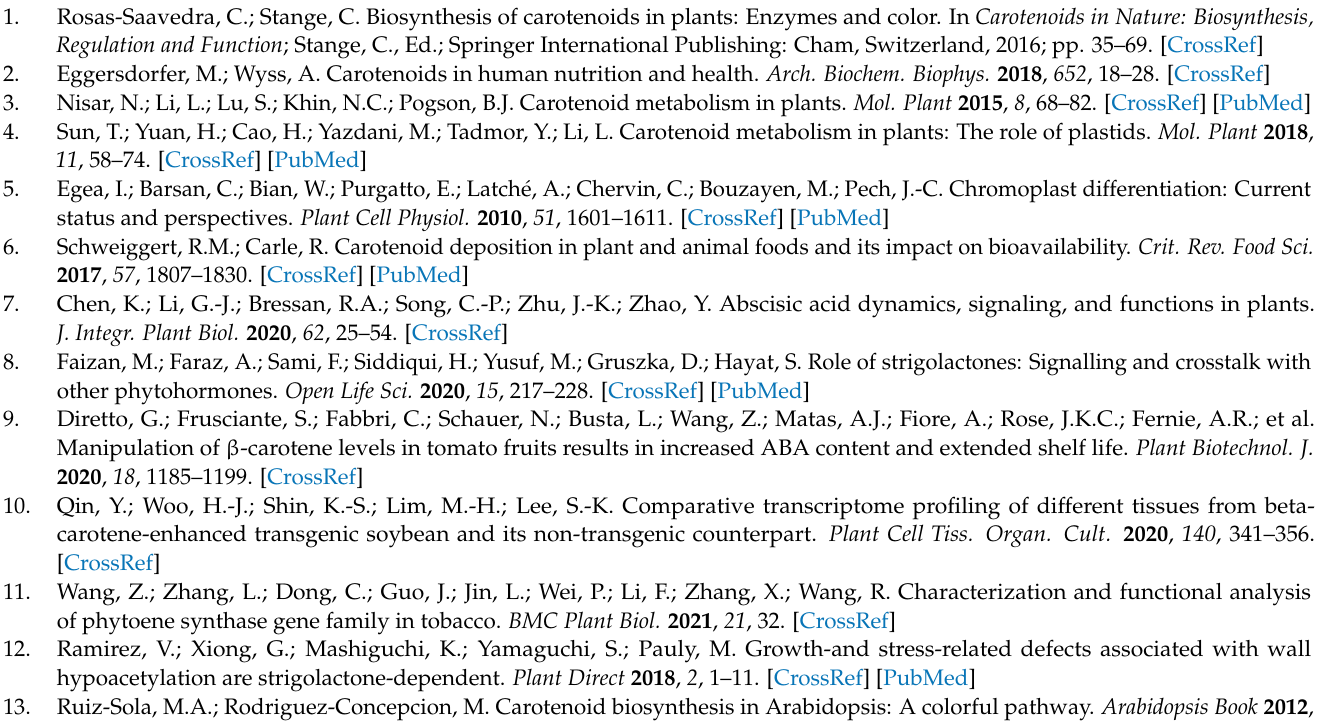
Figure S2: Morphology and structure of the wild type and psy2 mutant callus, Table S1: Primers used for PCR and qPCR, Table S2: Cellular epitopes localization and degree of their occurrence within the callus of different